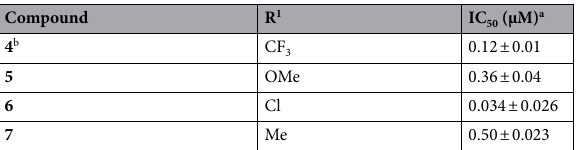
Table 1. MMP-1 inhibitory activity of compounds 4 – 7. a The compound concentration required for 50% inhibition (IC 50 ) was determined from semi-logarithmic dose–response plots, and the results represent the mean ± SD of triplicated samples. b Previously reported compound 13 .